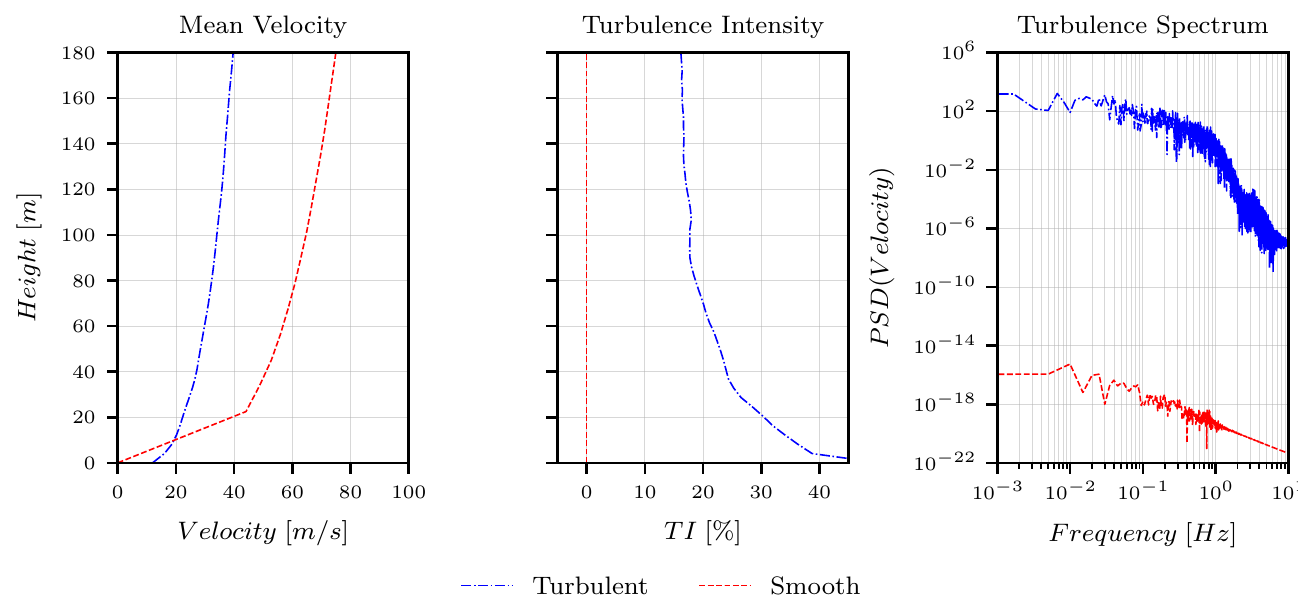
Figure 7. The typical metrics for characterizing the flow conditions: turbulent for the 0 ◦ angle of attack, smooth (i.e., low turbulent) for 90 ◦ angle of attack.